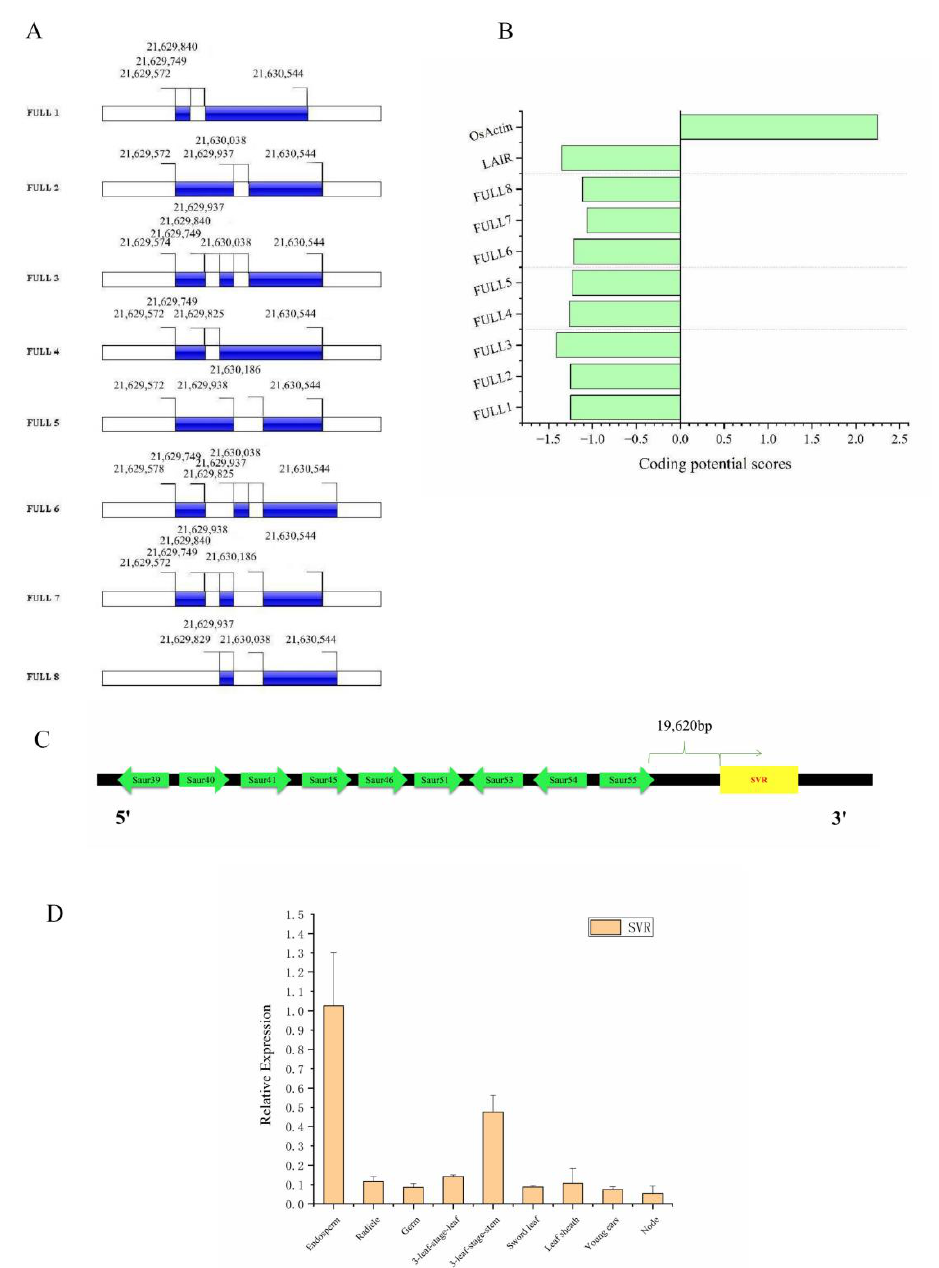
Figure 9. The genomic location, coding potential analysis, alternatively spliced isoforms and the spatial and temporal expression pattern of SVR. ( A ) The genomic locations of alternatively spliced SVR isoforms. FULL 1 represents SVR. ( B ) The coding potential scores of the isoforms calculated by CPC. Transcripts with scores beyond -1 and 1 are marked as noncoding or coding in this CPC classifi- cation. LAIR [13] and OsActin represent noncoding and coding examples, respectively. ( C ) Schematic diagram of the SAUR family gene cluster and SVR. SVR is 19.62 kb from the nearest SAUR family gene, OsSAUR55 . ( D ) The spatial and temporal expression pattern of